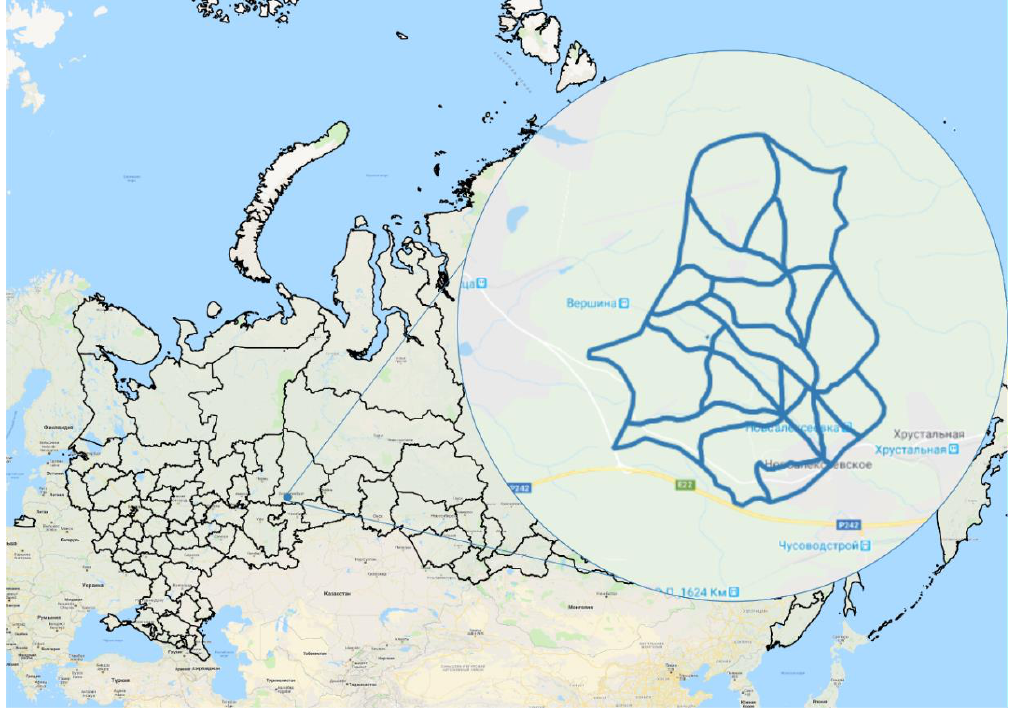
Figure 1. Location of the basin of the Reshetka river.